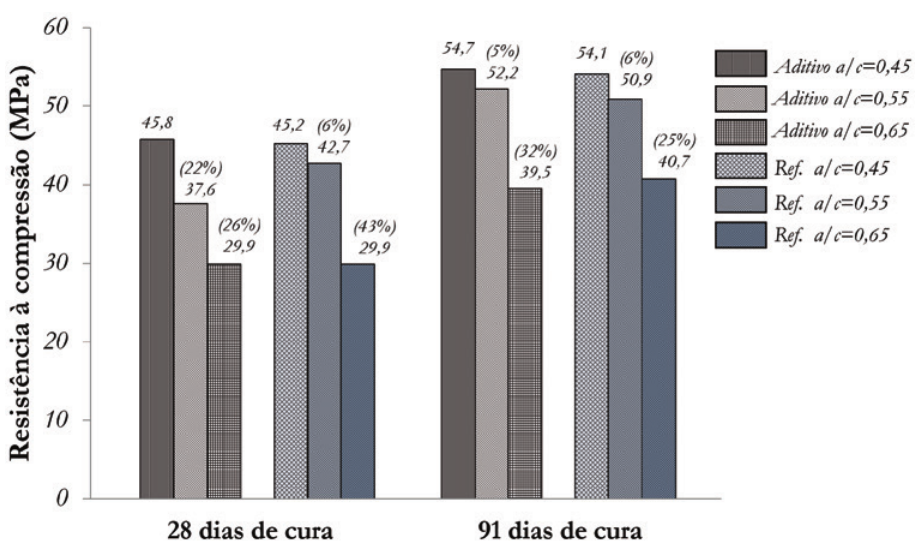
Influência do uso do aditivo na resistência à